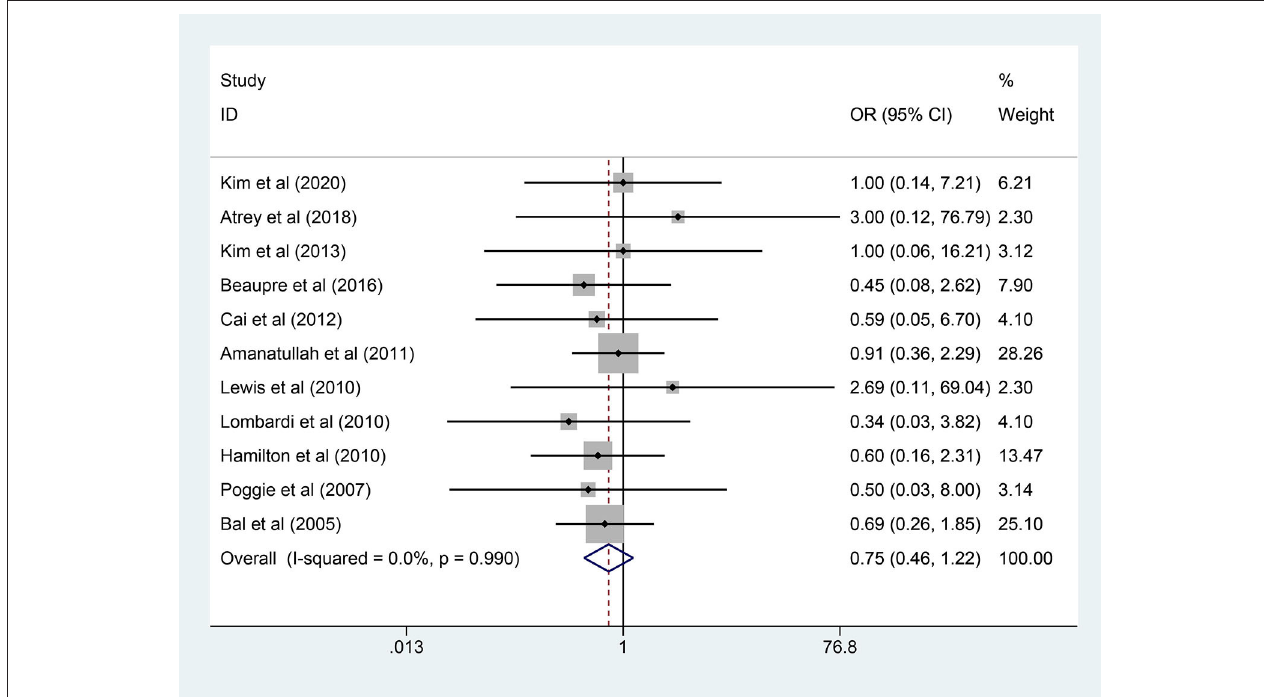
FIGURE 5 | Forest plot diagram of the dislocation rate of the replaced hip with COC and COP bearing